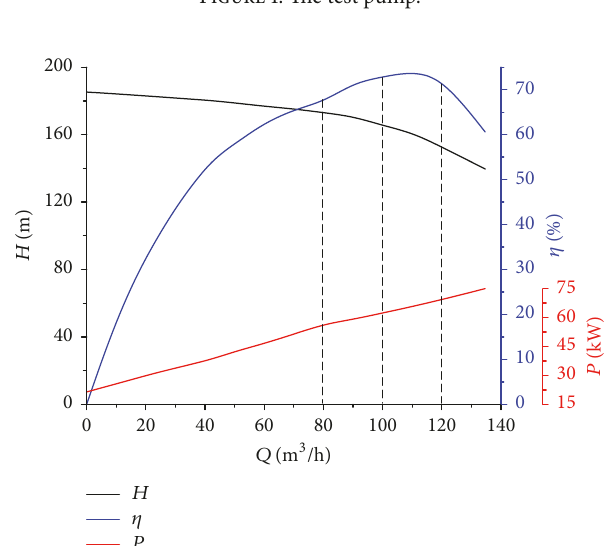
Figure 1: The test pump.